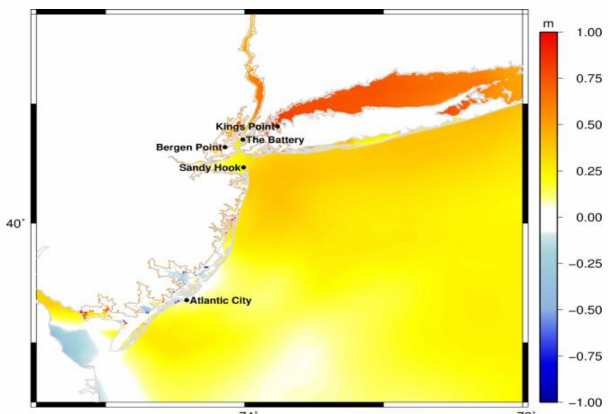
Figure 11. Difference in maximum water elevation between FWP12-4 and SCT12-4 (i.e., between track-forced simulation and the simulation forced with the full wind and pressure field output from WRF simulations of the same